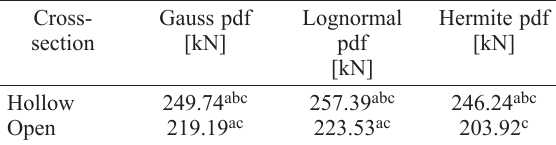
Table 6. 0.1 percentiles of LCC (design values)